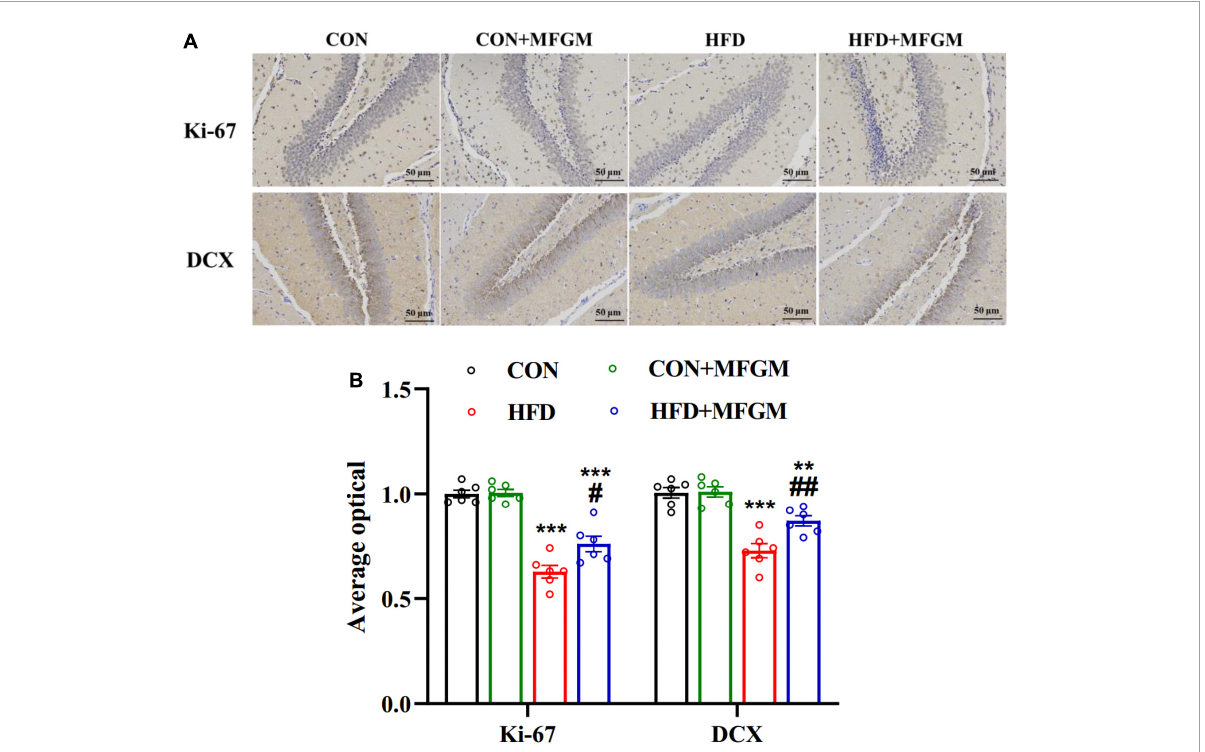
FIGURE2 Maternal supplementation with milk fat globule membrane during pregnancy and lactation promoted neurogenesis in weaned offspring from HFD dams. (A) Immunohistochemical staining and average optical density value of Ki-67 and DCX in the dentate gyrus of the offspring. (B) Average optical density value of Ki-67 and DCX, n = 6. Values are mean ± SEM. # P < 0.05 vs. HFD group. ** P < 0.01 vs. CON group. ## P < 0.01 vs. HFD group. *** P < 0.001 vs. CON